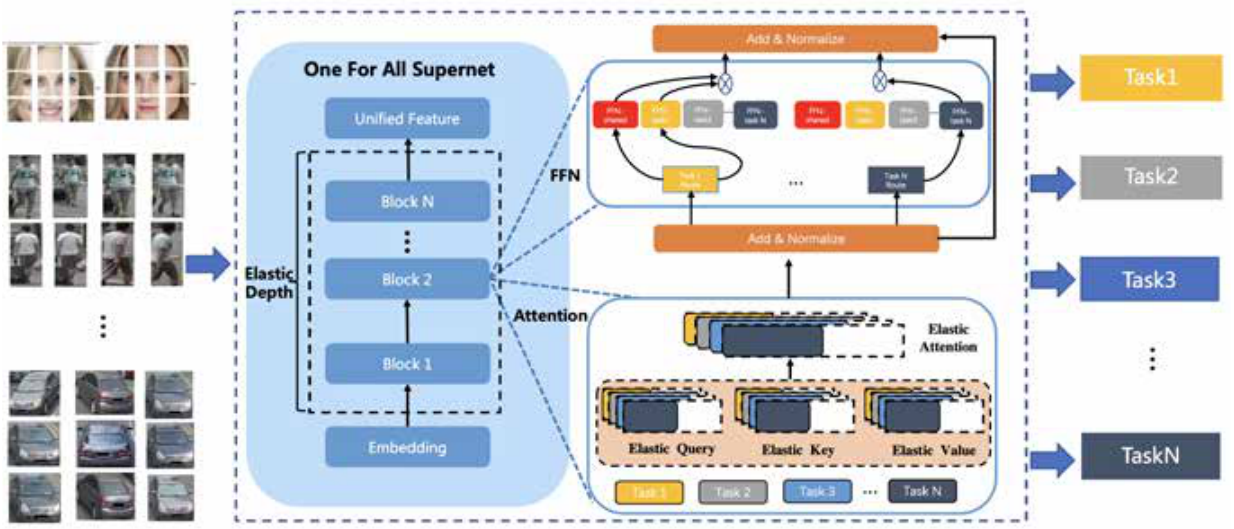
Figure 5 The Supernet is divided into two parts: multi-path FFN (Feed Forward Networks) and elastic attention. Models can select or cut some components from the already-learned unified model and apply to a wide range of downstream tasks, with the advantage of smaller model size and low Fig. 1. Overview of the UFO adaptation cost [19].